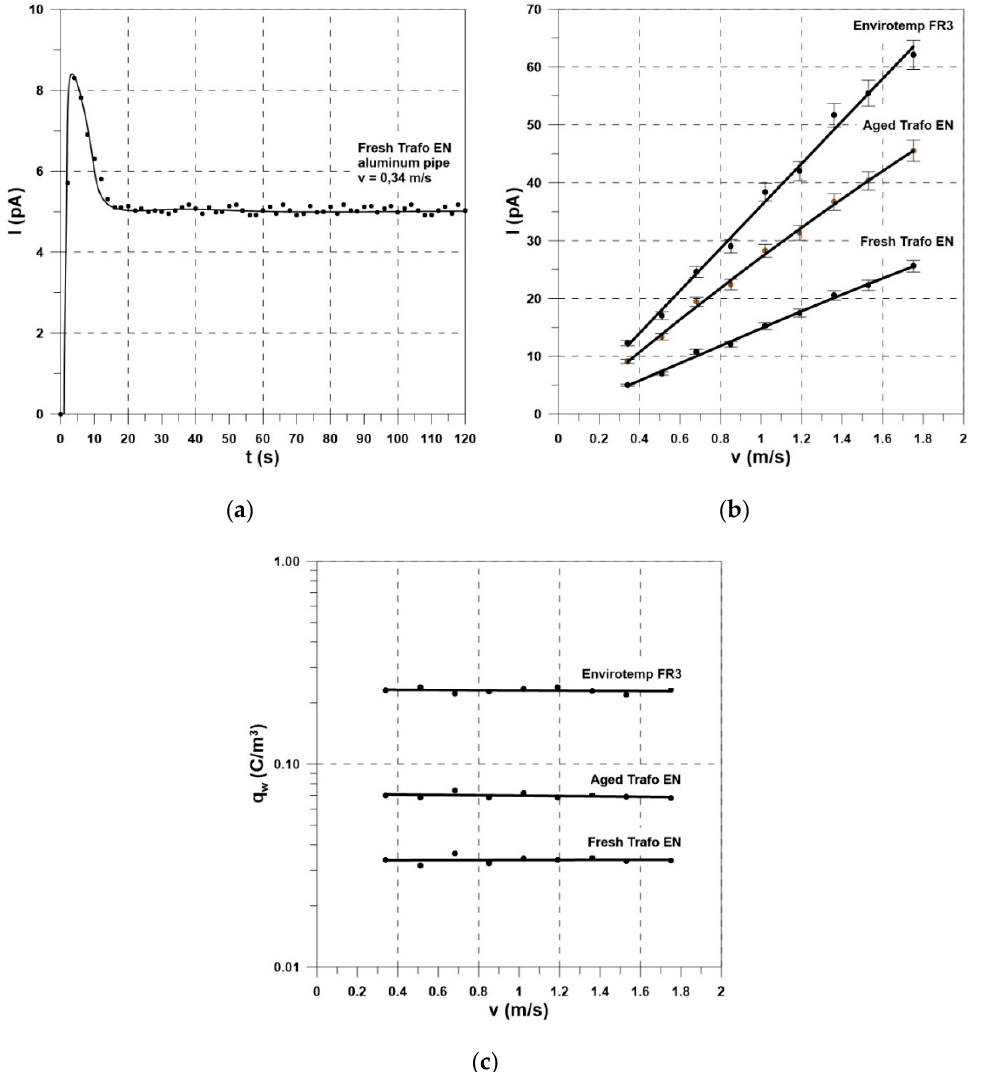
Figure 4. ( a ) Electrification current vs. flow time of Trafo EN mineral oil; ( b ) Electrification current and ( c ) volume charge density q w vs. flow velocity of insulating liquids through an aluminum pipe.